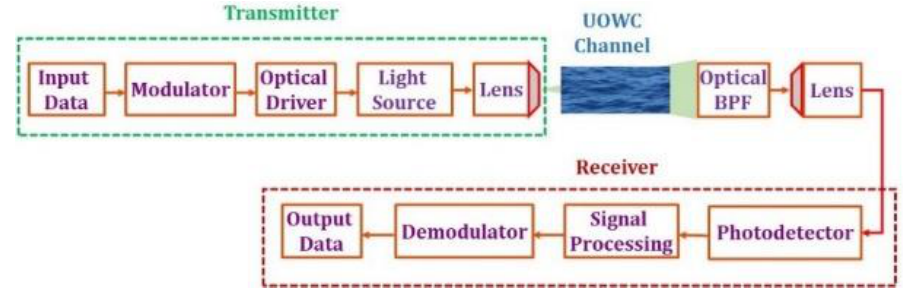
Figure 29. UWOC system architecture.